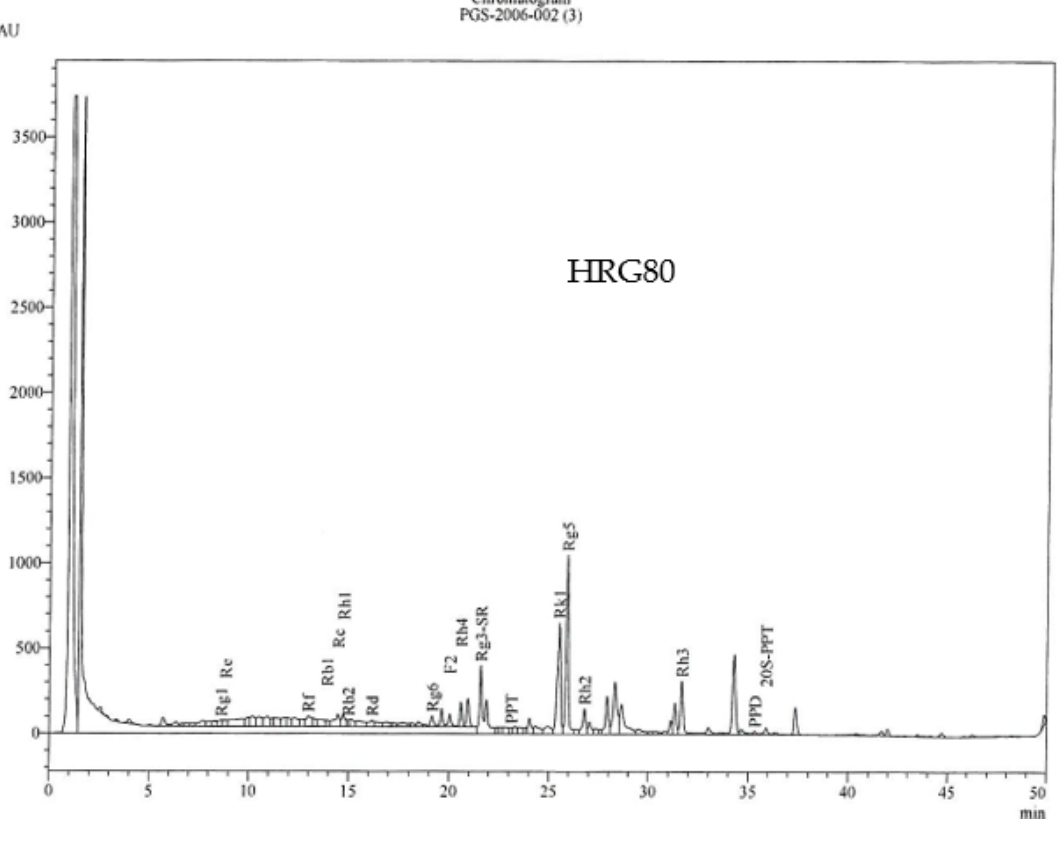
Figure 1. HRG80 TM HPLC fingerprint and composition (Item 11 in Supplementary Materials of [18]).